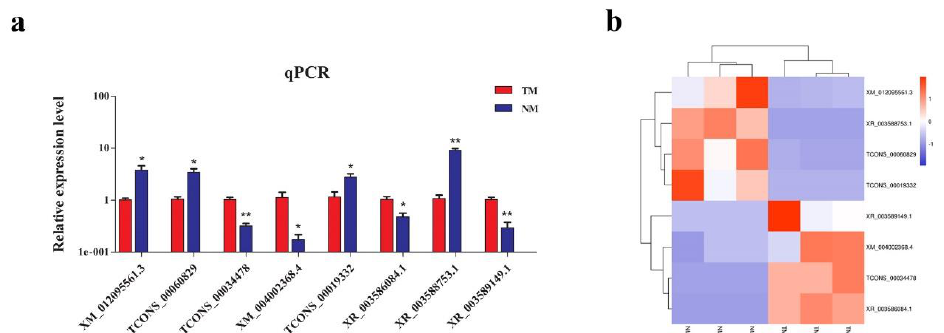
Figure 5. The verification of DE lncRNAs and mRNAs by qPCR. ( a ) Eight lncRNAs and mRNAs were randomly selected for qPCR verification and ( b ) shows the RNA-seq results of these eight DE lncRNAs and mRNAs. The qPCR results were expressed relative to the TM group as the mean values ± SEM and the relative expression levels were normalized to the expression levels of GAPDH . ** and * denotes the extremely significant and significant difference between two groups, p < 0.01 and p < 0.05.